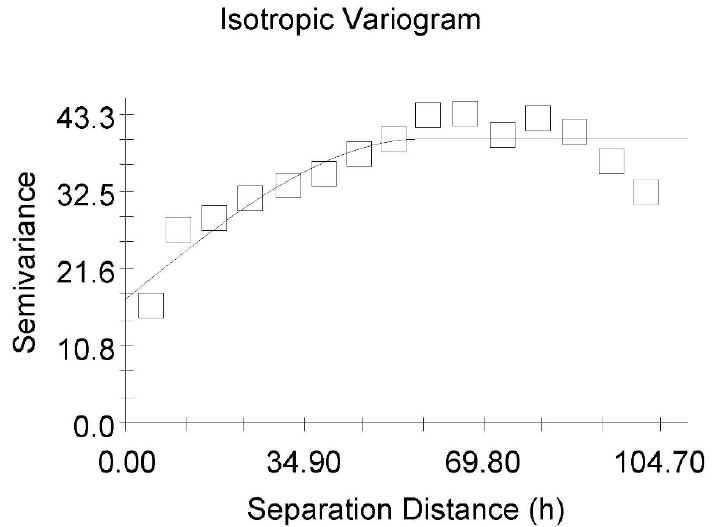
Figure 1. Semivariogram of VMC in the tillering stage with a spherical model.